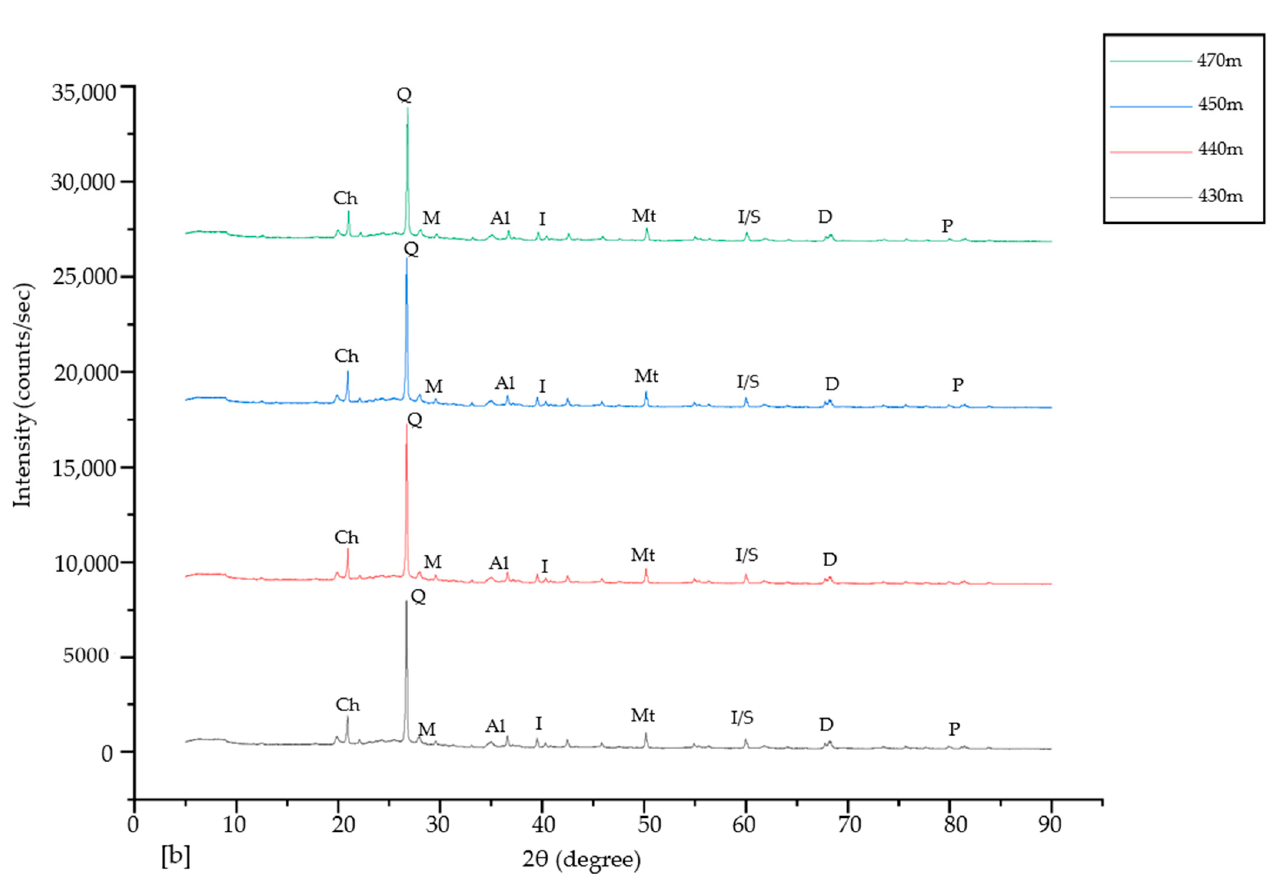
Figure 3. X-ray diffractogram patterns of the studied carbonaceous shale from depth ( a ) 370 m to 410 m ( b ) 430 m to 470 m (note: ch-chlorite, Q—Quartz, M—Microcline, Al—Albite, I—Illite, Mt—Montmorillinite, I/S—mixed layer Illite-Smectite, C—Calcite, D—Dolomite, P—Pyrite). Table 1. Mineral composition of the carbonaceous shale samples from different depths.